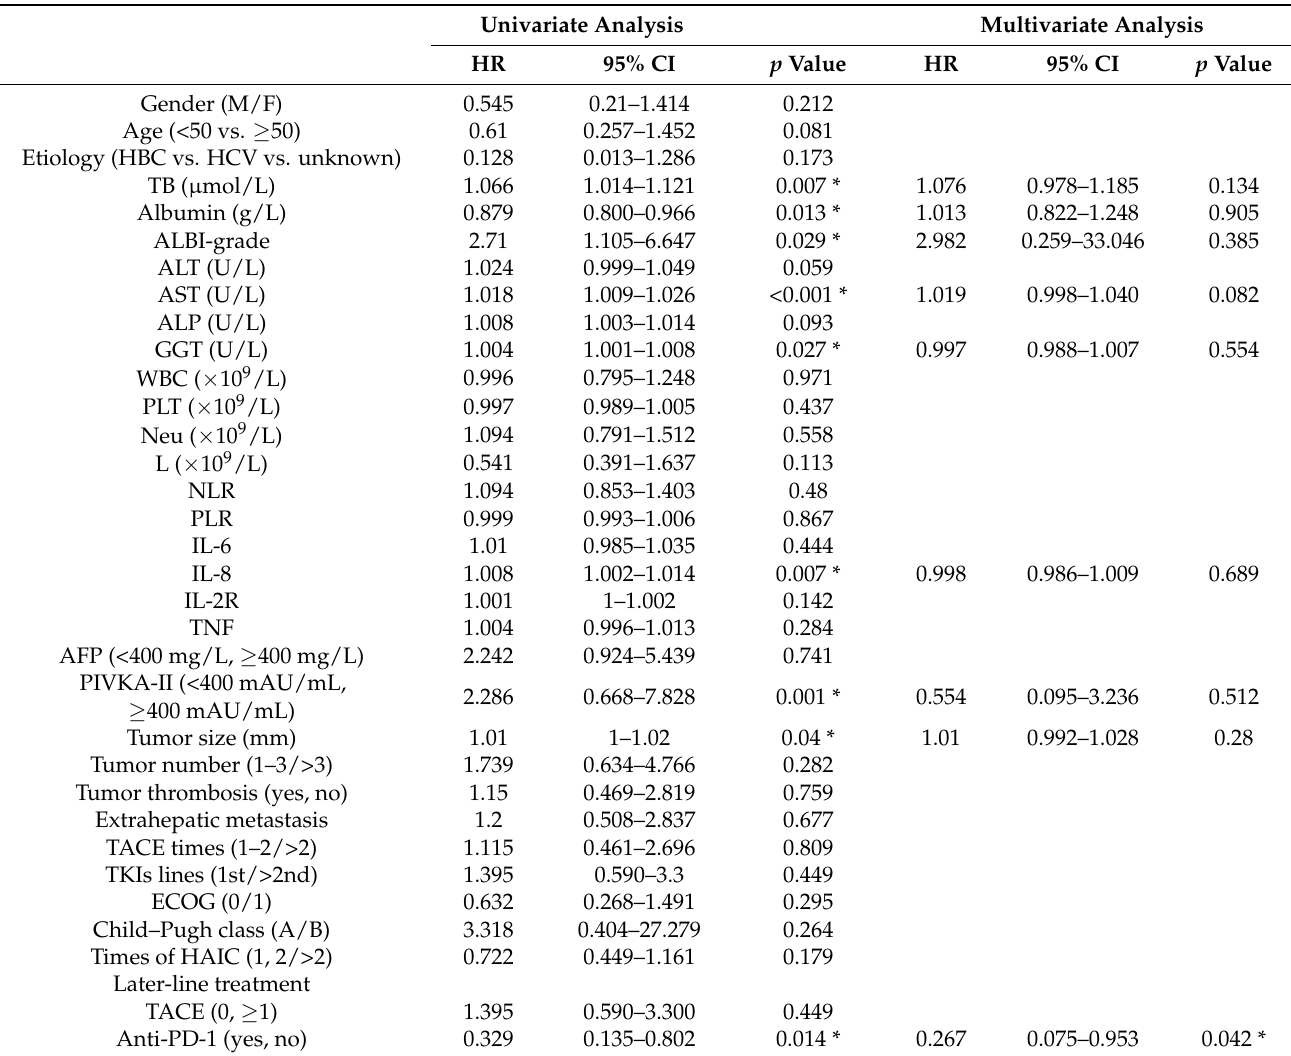
Table 4. Prognostic factors associated with overall survival in 35 patients (* p < 0.05 is considered statistically